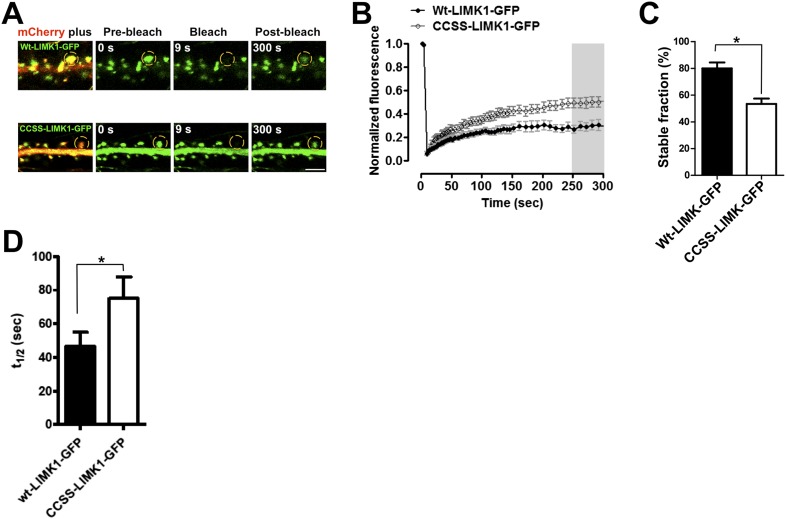
Palmitoylation helps to anchor LIMK1 in spines.(A) Hippocampal neurons (DIV18) were transfected with the indicated GFP-tagged LIMK1 cDNAs plus morphology marker (mCherry). 18–24 hr post-transfection, a ROI centered on an individual spine (yellow circle) was photobleached (third column) and fluorescence recovery was monitored (right column). (B) Quantified FRAP from n = 12–18 spines per condition from A. (C) Histogram of the stable fraction of wt- and CCSS-LIMK1-GFP, calculated as in ‘Materials and methods’. *p < 0.05, t-test. (D) Histogram of the half-time of recovery of the dynamic fraction of mobile LIMK1-GFP, determined by fitting individual fluorescence recovery traces to a single exponential. * p < 0.05, t-test. Although this result is statistically significant, note that the determination for wt-LIMK1-GFP is affected by the very low fraction of recovery seen in many individual traces, which reduces the accuracy of curve-fitting. Recovery half-times for wt- and CCSS-LIMK1-GFP are markedly longer than other proteins that are predicted to be freely soluble in spines (Star et al., 2002; Bingol et al., 2010; Zheng et al., 2010).